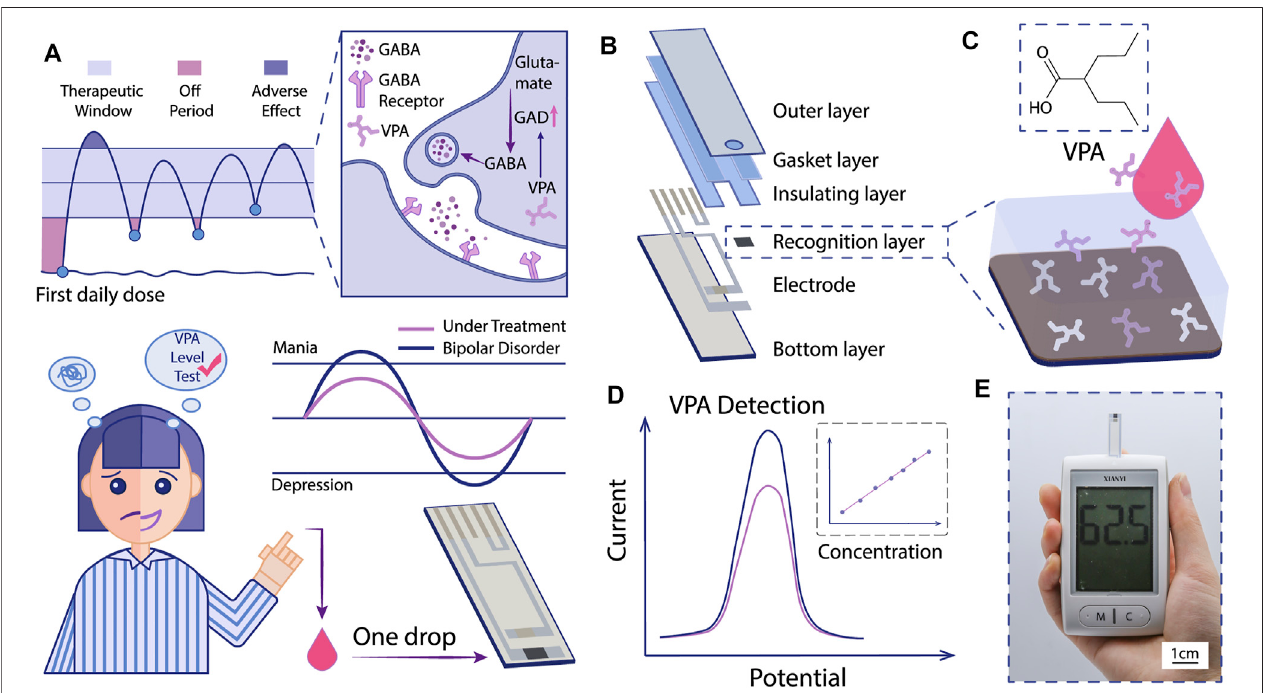
FIGURE 1 | Schematic illustration of the MIP-based electrochemical sensor for VPA-POCT. (A) The mechanism of VPA for BD treatment and the hopeful applicationofMIP-basedelectrochemicalsensorforVPA-POCT.GAD: glutamicaciddecarboxylase.GABA:gamma-aminobutyricacid. (B) Thestructure ofthesensor. Speci fi c binding of VPA molecules to MIP (C) induced a signal change (D) . (E) The recorded signals can be interpreted into VPA concentrations with a portable